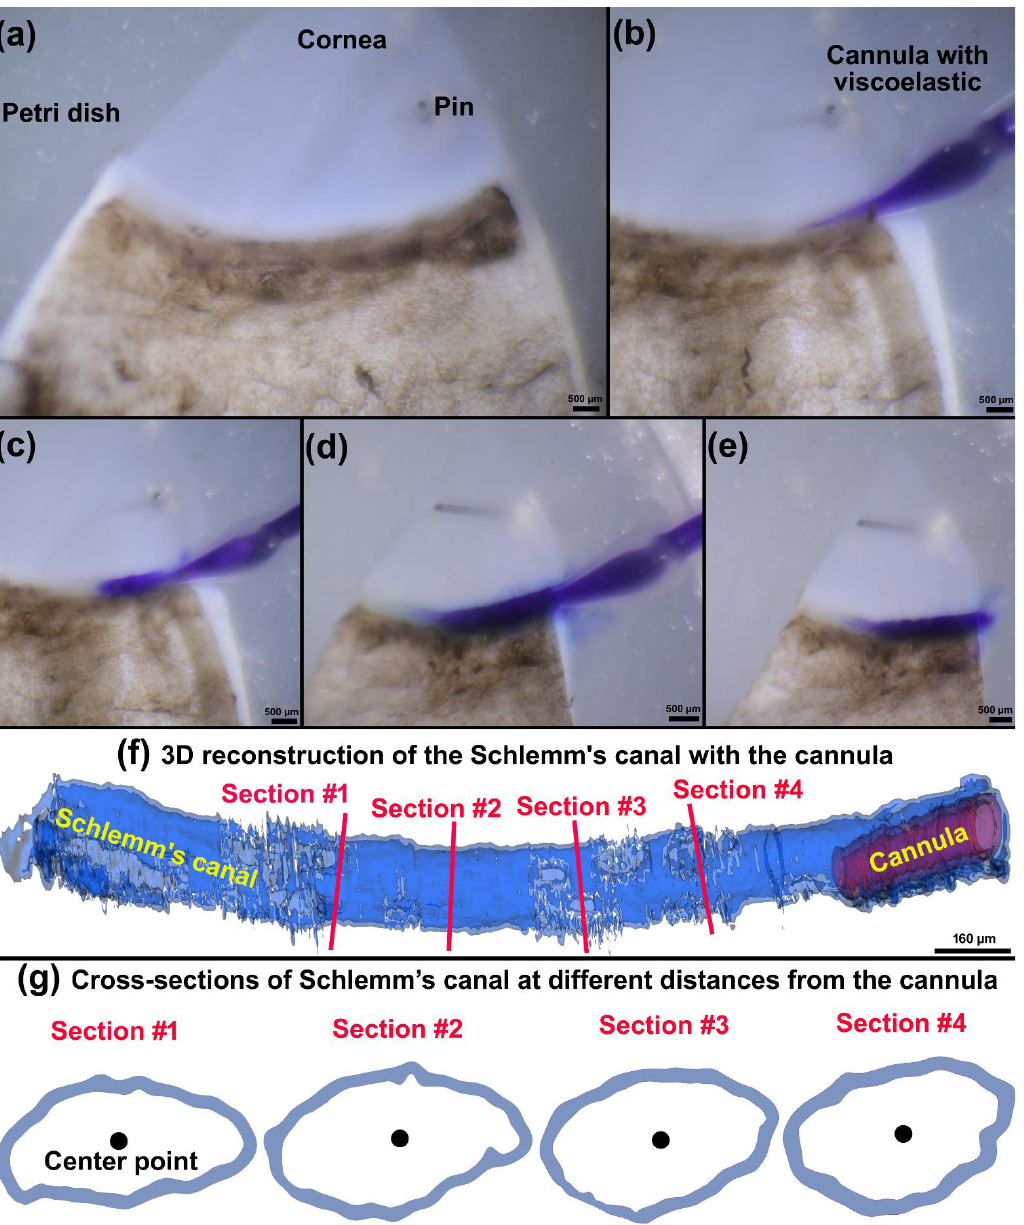
Figure 3. ( a ) A quadrant of the anterior segment was pinned in a Petri dish. ( b ) The SC was cannulated and ( c , d ) the viscoelastic was injected into the SC. ( e ) Once the viscoelastic is started to flow back from the SC lumen we removed the cannula. ( f ) The 3D reconstruction of the SC with the cannula after viscoelastic injection. ( g ) Cross-sections of the SC at different distances from the cannula. The distance between each cross section is ~200 µm.